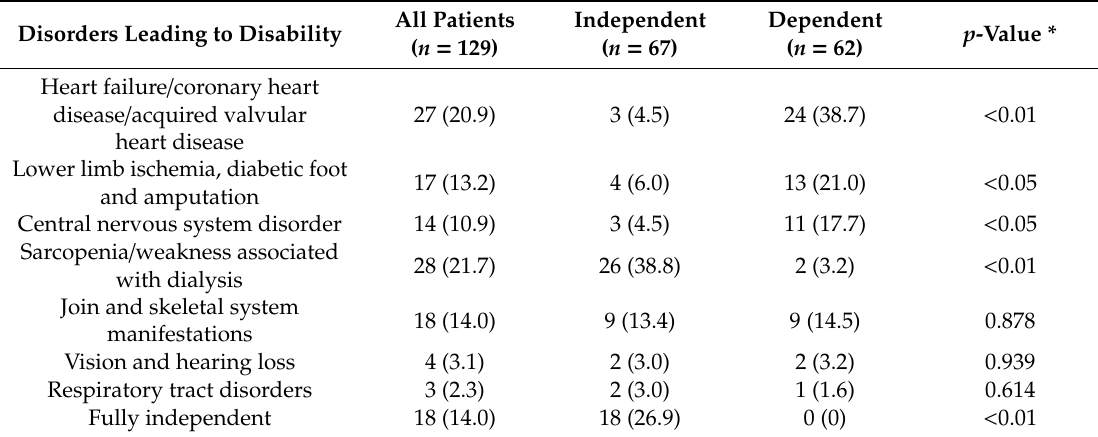
Table 3. Disorders leading to disability.